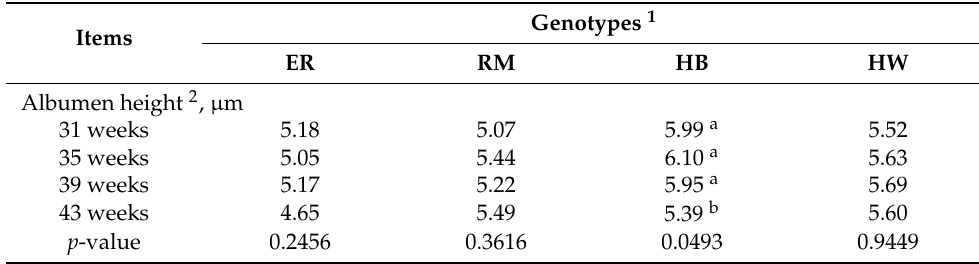
Table 4. Effect of age on albumen height and Haugh Units of stored 7 d eggs according to the genotype of the